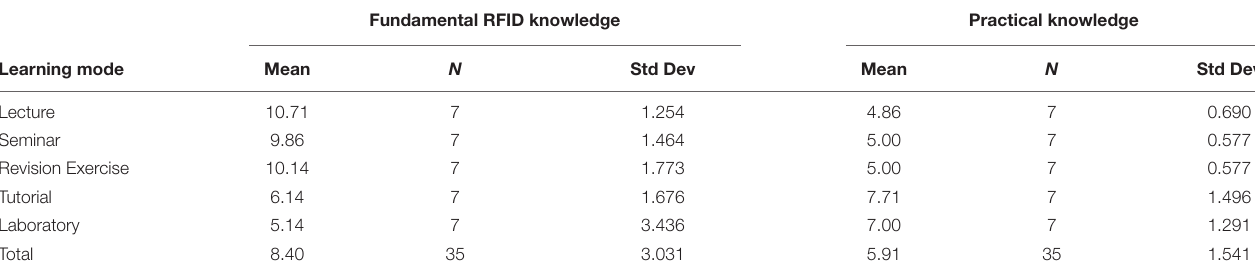
TABLE 5 | Group-based post-test measurements for learning performance.